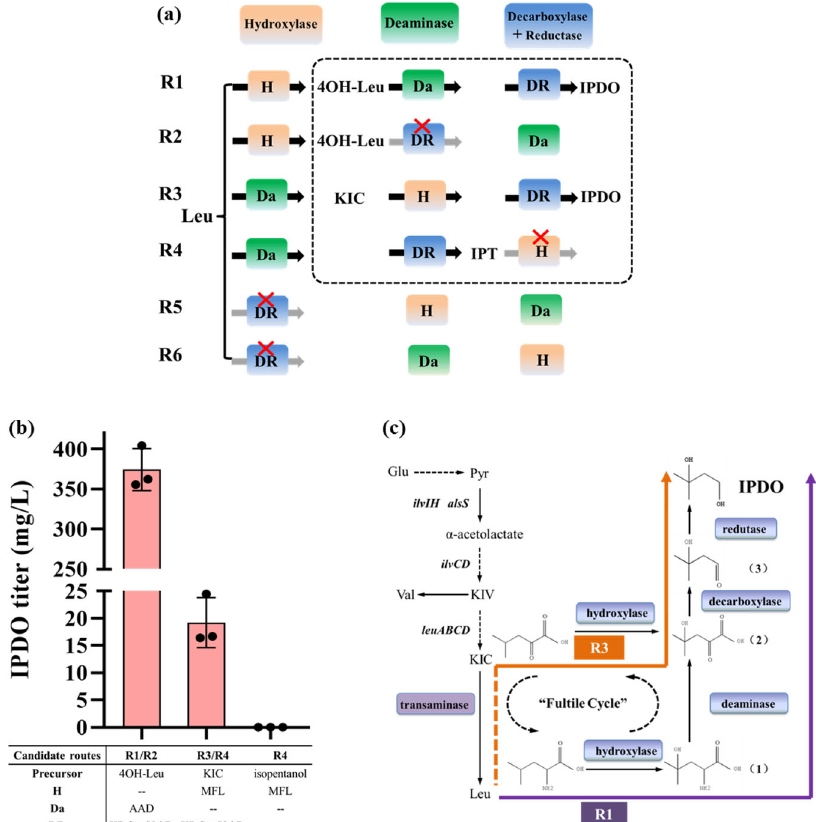
Fig. 3 Determination of reaction orders to construct a pathway for IPDO production from leucine or its precursor 2-ketoisocaproate (KIC) in E. coli . a Six possible reaction orders (R1-R6) in the proposed pathway for IPDO production. Since the reduction of aldehyde by aldehyde reductase is always after decarboxylation of α -keto acid by α -keto acid decarboxylase, these two reactions are considered as one single step (DR). Black arrows represent the reactions with proved functions in vivo, while gray arrows with red × represent the reactions that do not work in vivo. Precursors and enzymes in dotted boxes were employed for veri fi cation of each possible reaction order. b IPDO titers obtained from E. coli strains to carry different candidate routes. IPDO production was initiated by different strains cultivated in FM-II medium supplementing 5 mM precursor (4OH-Leu for strain DL01-R12, KIC for strain DL01- R34, and isopentanol for strain DL01-R4). 4OH-Leu: 4-hydroxy-leucine, KIC: 2-ketoisocapraote, IPT, isopentanol. c Two veri fi ed routes for the production of IPDO in E. coli . Route R1 was shown in purple and R3 in orange. A transaminase-deaminase fultile cycle existed in route R1. The deamination reaction of Route 3 is a fi ctitious reaction that is indicated by a dashed line. For b, the average and s.d. of three biologically independent experiments are shown. Source data are provided as a Source Data fi